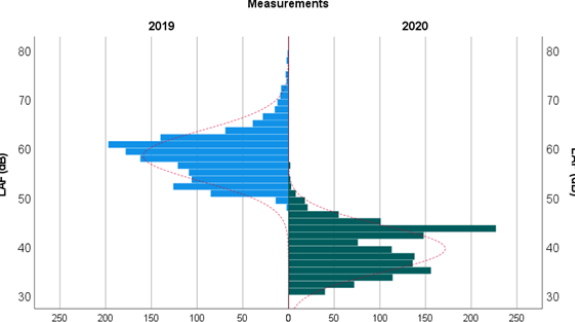
Figure 5: Aggregated (all four sites) LAF values distributions, split